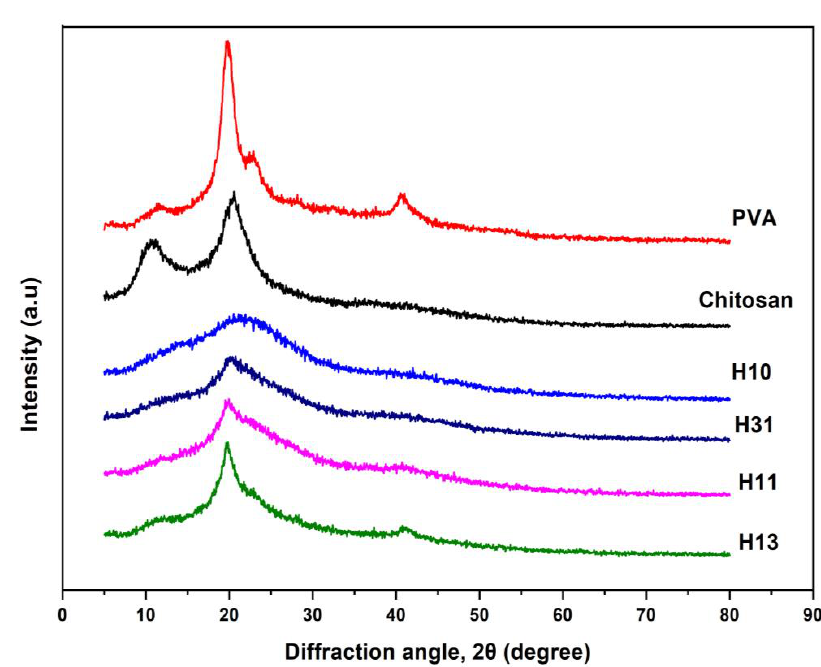
Figure 4. XRD patterns of chitosan, H 10 , PVA, H 13 , H 11 and H 31 .